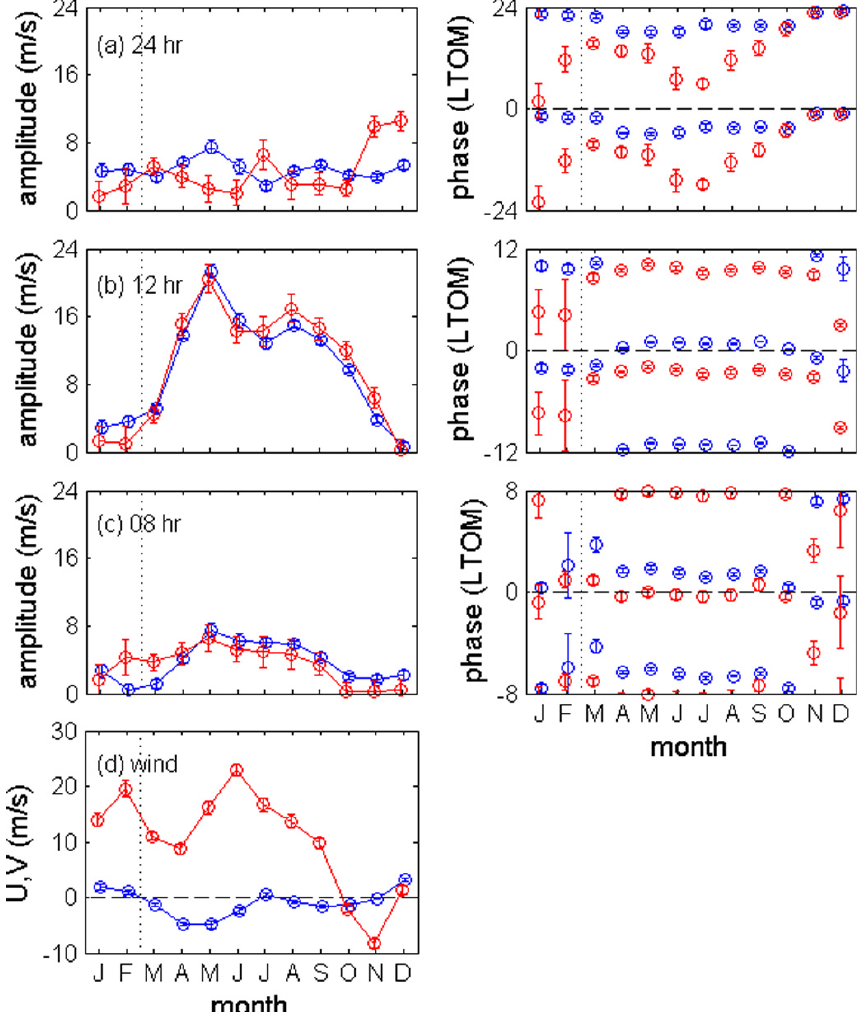
Fig. 7. Monthly mean amplitude and phase of the zonal (red; positive eastward) and meridional (blue; positive northward) components of the 24-h (a) , 12-h (b) , and 8-h (c) waves, and the background wind (d) . Wave phases are plotted as the local time of maximum (LTOM) and are repeated over two cycles to show coherence. Error bars represent 95% confidence intervals on the monthly mean